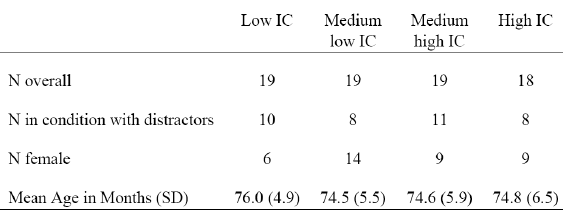
A total of 38 children (19 girls and 19 boys) with a mean age of 6 years and 3 months (SD = 5 months) were assigned to the experimental condition without